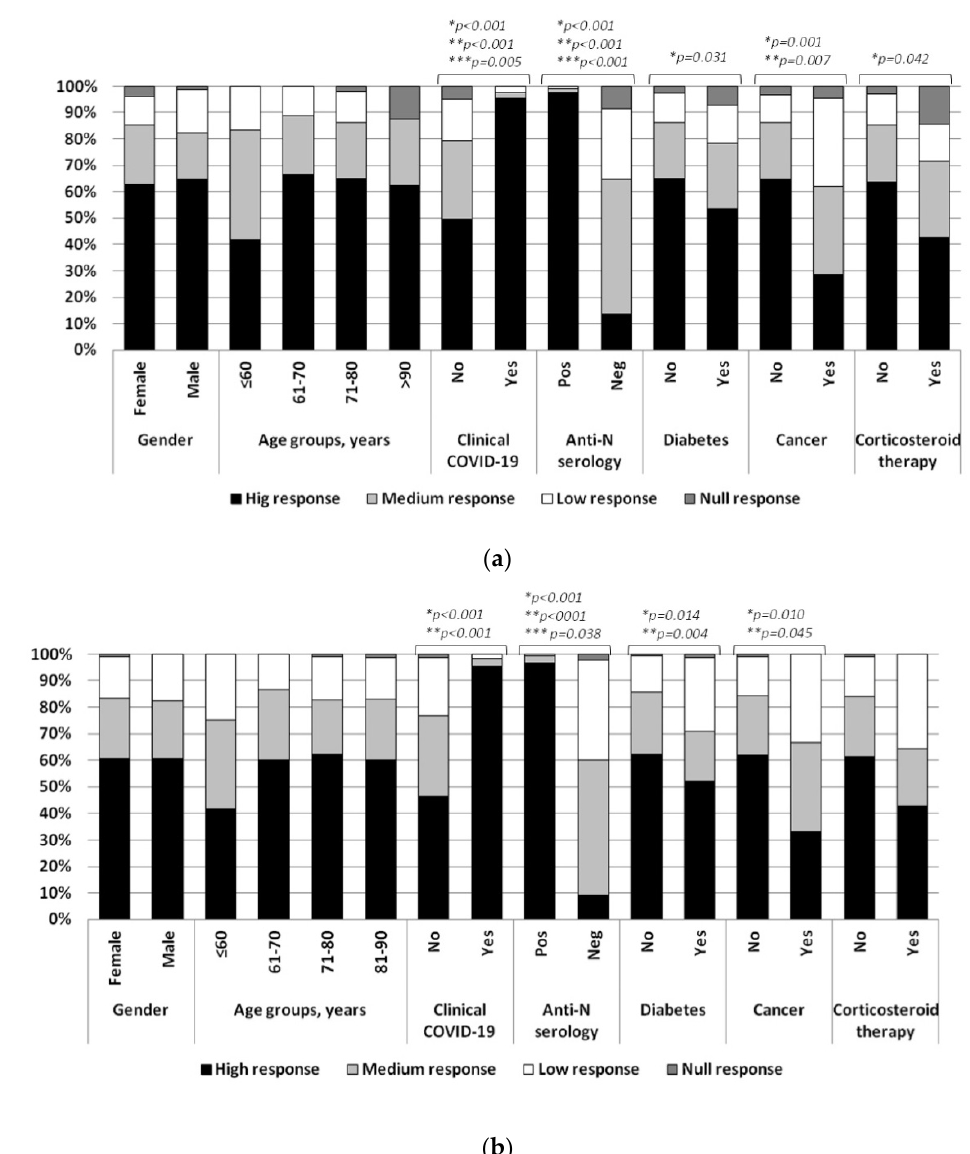
Figure 1. ( a ) Grade of response to SARS-CoV-2 vaccine at 1st and ( b ) at 2nd time points. * Overall response (high, medium, low and null); ** Suboptimal response (high and medium vs. low and null); *** Null response (high, medium and low vs.